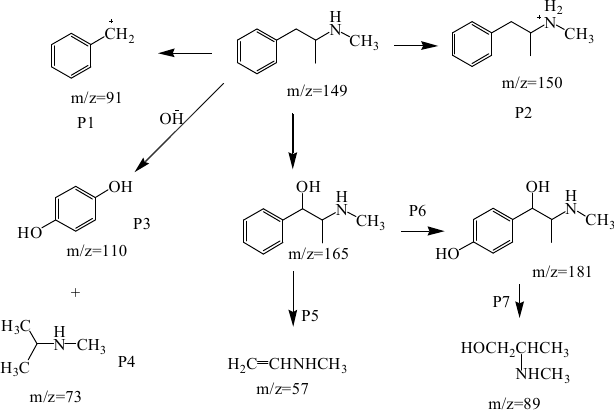
Figure 13. Tentative transformation of METH pathways in the UV/H 2 O 2 system.